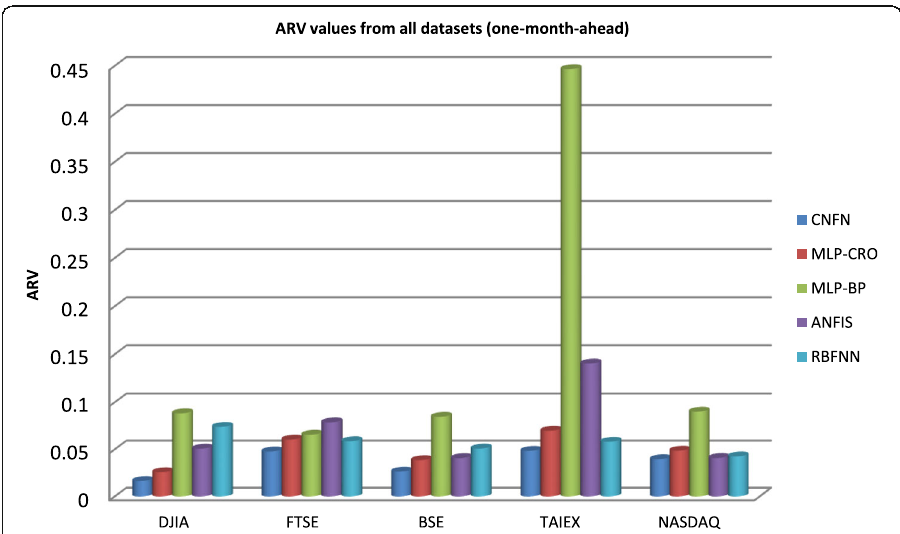
Fig. 13 ARV generated by all models from all datasets